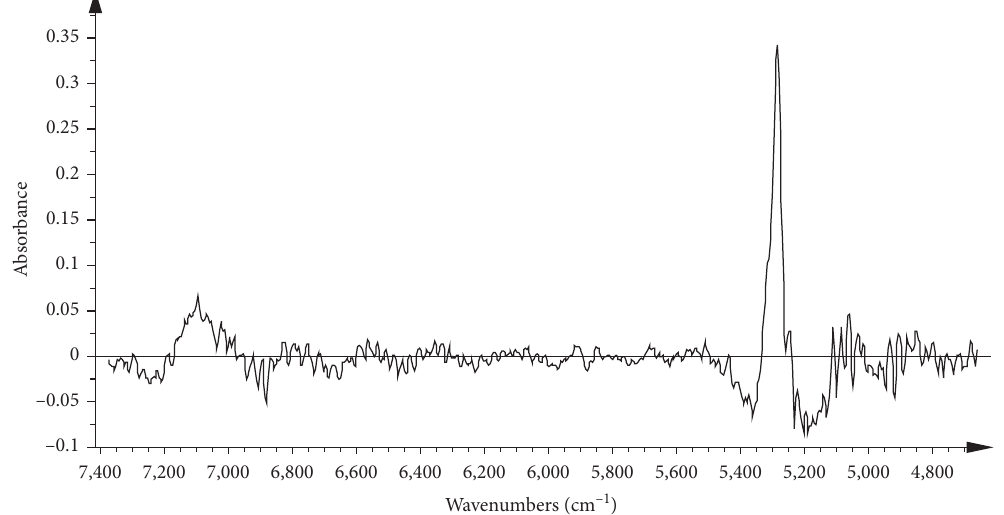
Figure 6: The first loading factor spectra of the PCR model for the moisture content prediction.